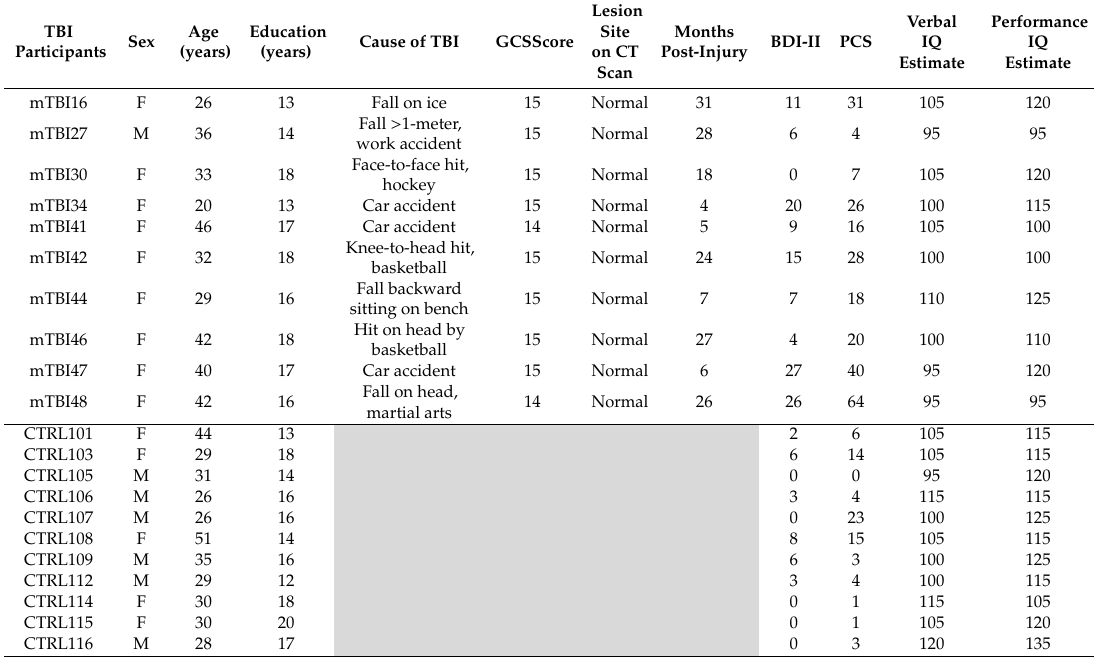
Table 1. Demographic and clinical characteristics of the mTBI and control